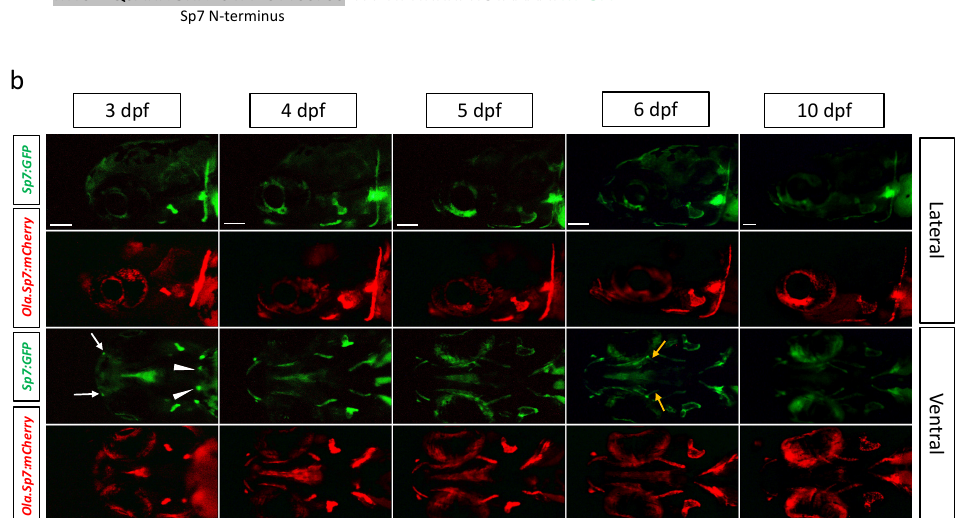
Figure 2. GFP expression in the Tg(sp7:sp7-GFP) transgenic line. ( a ) N-terminal end of the fusion protein produced by the Tg(sp7:sp7-GFP) transgenic line, with the predicted signal peptide in grey and the original GFP translational start site (M) in green. ( b ) Transgene expression in the Tg(sp7:sp7-GFP) and the previously described Tg(Ola.Sp7:mCherry) lines tracked in the head region (top: lateral view and bottom: ventral view) from 3 dpf to 10 dpf. Earlier transgene expression occurs in the maxillary (white arrows) and pharyngeal tooth buds (white arrowheads) at 3 dpf and in the entopterygoid (yellow arrows) at 6 dpf of the Tg(sp7:sp7-GFP) line. The scale bars, given in the left bottom corner of the images in the top row, correspond to 100 µm.